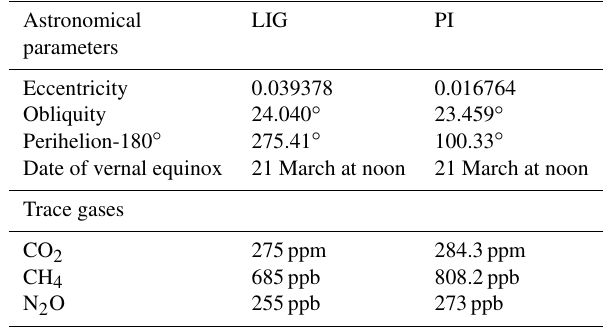
Table 3. Astronomical parameters and atmospheric trace gas con- centrations used to force LIG and PI